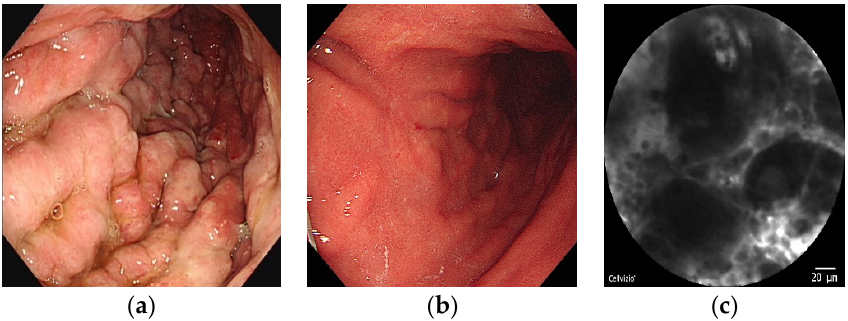
Figure 2. Images of a representative case of residual gastric cancer detected on pCLE. ( a ) Borrmann type IV advanced gastric cancer at initial diagnosis; ( b ) Scarring and subtle thickening of the mucosa after chemotherapy; ( c ) A disorganized and irregular thickened epithelium on pCLE. pCLE, probe- based confocal laser endomicroscopy.